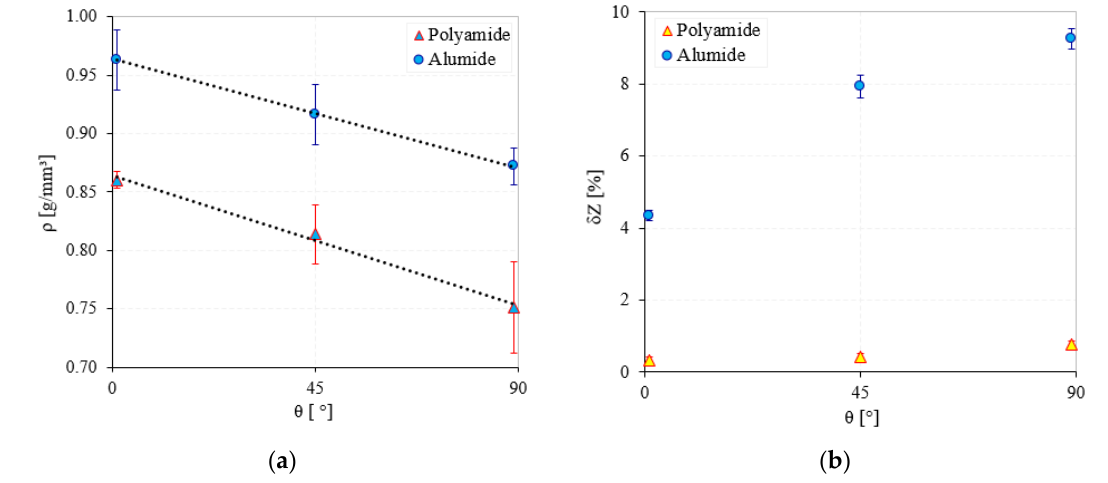
Figure 5. Density ( a ) and Z deflection ( b ) of polyamide and Alumide samples.